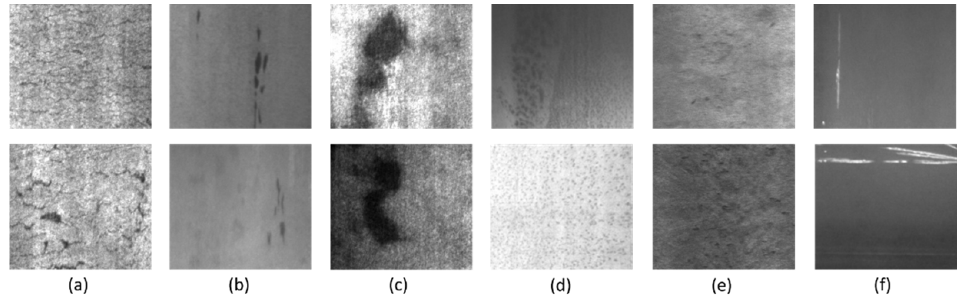
Figure 2. Examples of NEU-DET datasets include ( a ) Crazing, ( b ) Inclusion, ( c ) Patches, ( d ) Rolled-in Scale, ( e ) Pitted Surface and ( f )